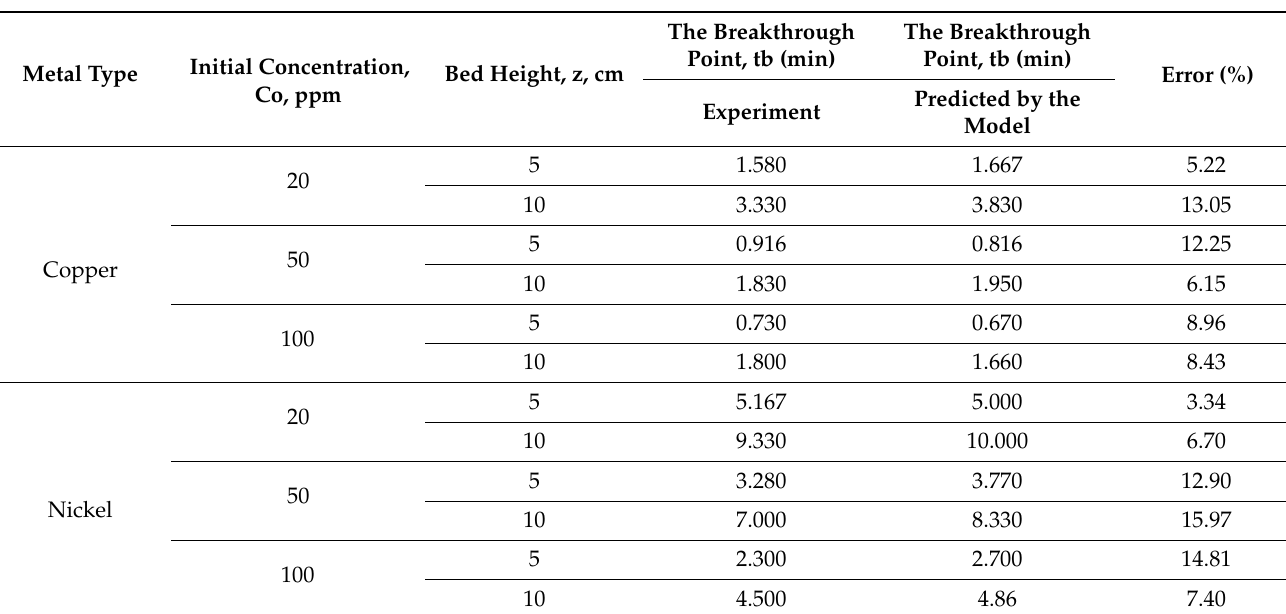
Table 2. Experimental